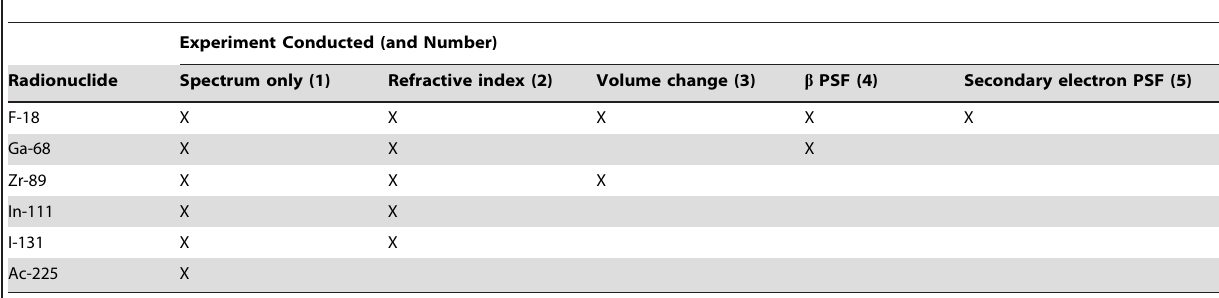
Table 3. Radionuclides tested and the types of experiments conducted on each.